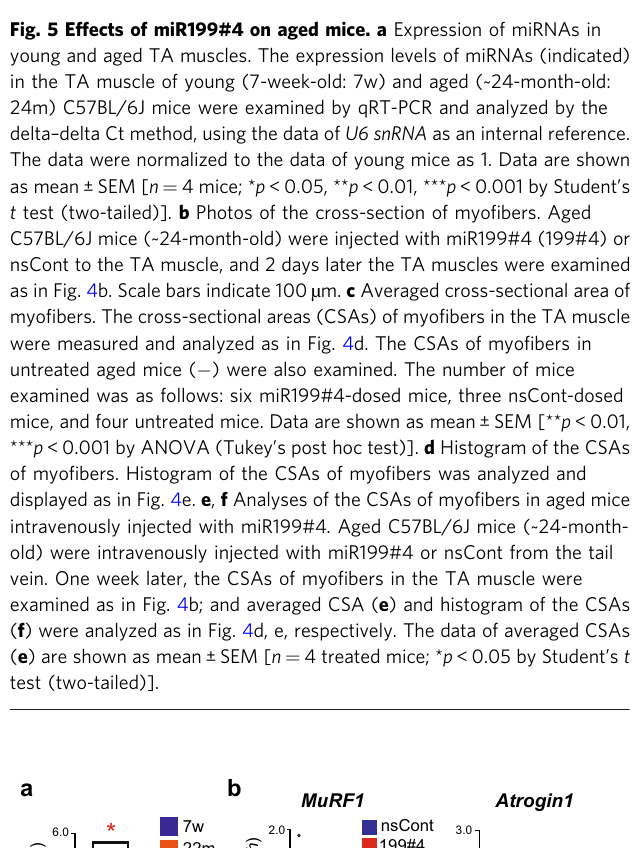
Fig. 5 Effects of miR199#4 on aged mice. a Expression of miRNAs in young and aged TA muscles. The expression levels of miRNAs (indicated) in the TA muscle of young (7-week-old: 7w) and aged (~24-month-old: 24m) C57BL/6J mice were examined by qRT-PCR and analyzed by the delta – delta Ct method, using the data of U6 snRNA as an internal reference. The data were normalized to the data of young mice as 1. Data are shown as mean ± SEM [ n = 4 mice; * p < 0.05, ** p < 0.01, *** p < 0.001 by Student ’ s t test (two-tailed)]. b Photos of the cross-section of myo fi bers. Aged C57BL/6J mice (~24-month-old) were injected with miR199#4 (199#4) or nsCont to the TA muscle, and 2 days later the TA muscles were examined as in Fig. 4b. Scale bars indicate 100 µ m. c Averaged cross-sectional area of myo fi bers. The cross-sectional areas (CSAs) of myo fi bers in the TA muscle were measured and analyzed as in Fig. 4d. The CSAs of myo fi bers in untreated aged mice ( − ) were also examined. The number of mice